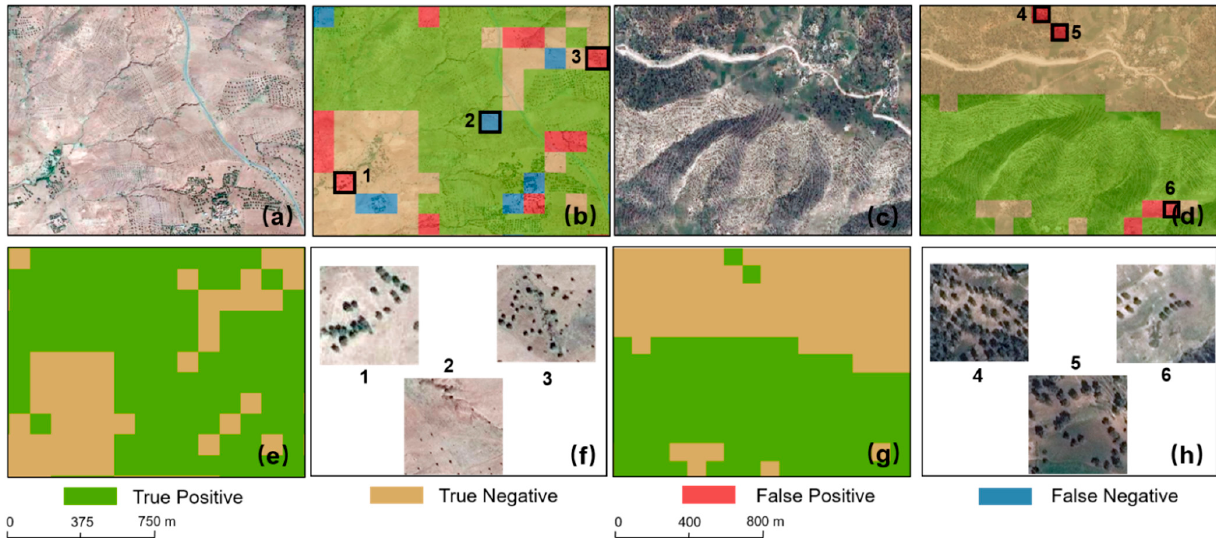
Figure 8. Olive mapping results using the grid sampling approach and DG imagery. The legend only applies to ( b , d ). ( a ) RGB imagery in grid 5, semi-arid site 5; ( b ) classification map showing TP/TN/FP/FN in grid 5, semi-arid site 5; ( c ) RGB imagery in grid 4, sub-humid site 9; ( d ) classification map showing TP/TN/FP/FN in grid 4, sub-humid site 9; ( e ) classification map in grid 5, semi-arid site 5; ( f ) examples for false positive and false negative values in grid 5, semi-arid site 5; ( g ) classification map in grid 4, sub-humid site 9; ( h ) examples of false positive and false negative values in grid 4, sub-humid site 9.